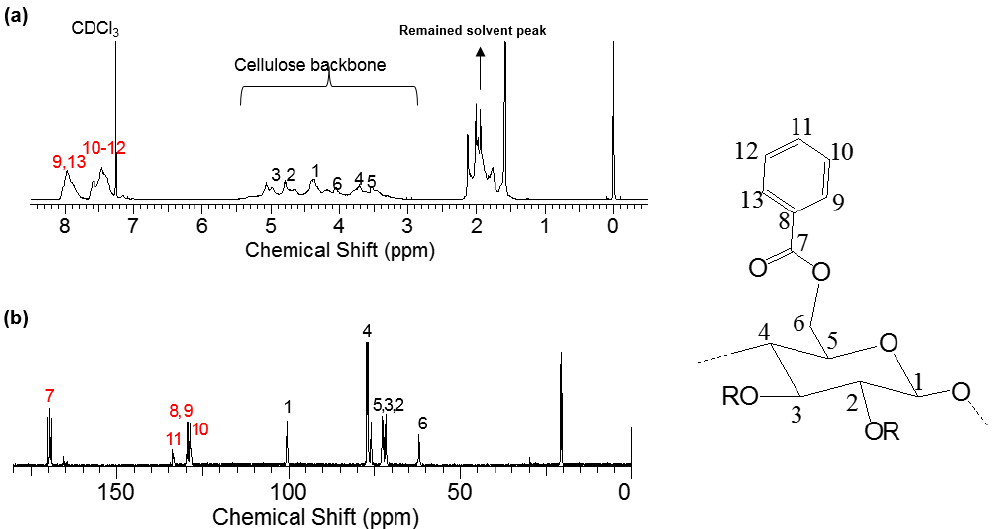
Figure 1. 1 H NMR spectrum ( a ) and 13 C NMR spectrum ( b ) of the Bz–Cell.